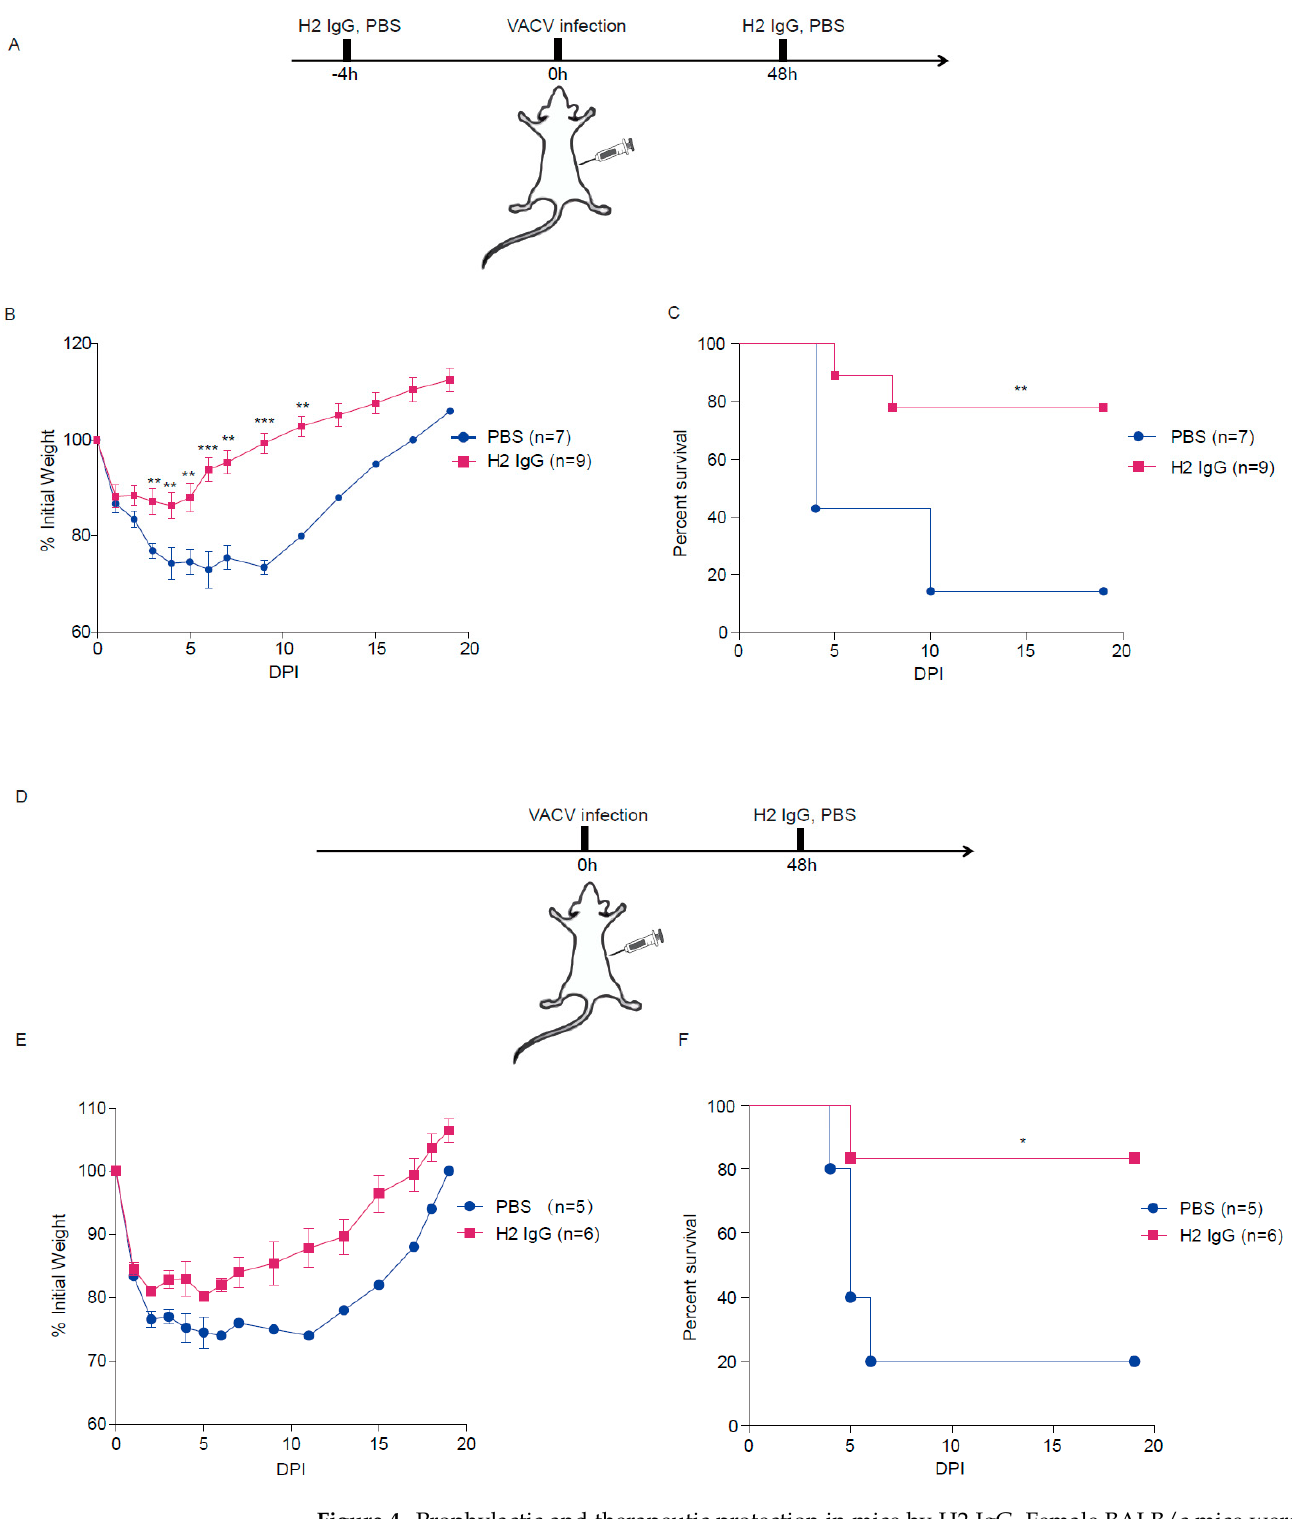
Figure 4. Prophylactic and therapeutic protection in mice by H2 IgG. Female BALB/c mice were infected i.p. with 5 × 10 6 PFU VACV. H2 IgG was administered in mice (22 mg/kg) at the indicated time points. ( A ) Schematic diagram of prophylactic treatment with H2 IgG in mice. ( B ) Weight change following VACV infection. ( C ) Survival curves following VACV infection. ( D ) Schematic diagram of treatment with H2 IgG in mice. ( E ) Weight change following VACV infection. ( F ) Survival curves following VACV infection. Data are from at least two independent experiments, with 3–5 mice per group in each experiment. * p < 0.05, ** p < 0.01, *** p <